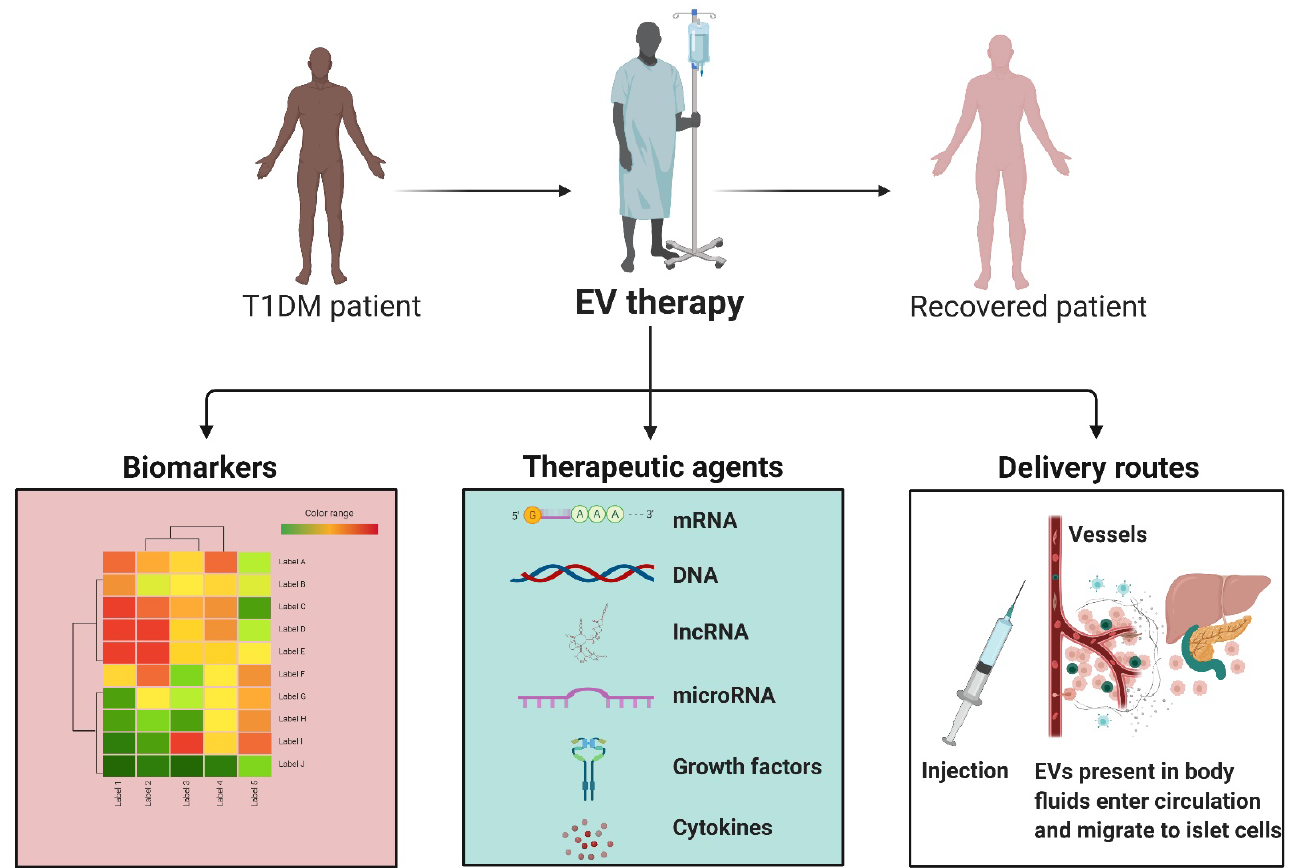
Figure 4. EVs in T1DM. EVs can play a valuable role in T1DM. There are a number of RNAs and proteins that are modified in EVs in T1DM and rejected transplants. In addition, the natural components of EVs from a healthy system, such as anti-inflammatory cytokines or micRNAs, can aid in regulating and correcting a disease state. Moreover, EVs can be loaded with particular cargos and delivered alongside transplantation to aid in graft survival and long-term well-being. EVs can be are delivered into the bloodstream where they migrate to distant tissues such as pancreatic islets of Langerhans and are engulfed by target cells. As the EV payload is delivered into a target cell, the proteins and RNA species can have various impacts, triggering diverse cell signaling cascades and the regulation of gene expression.